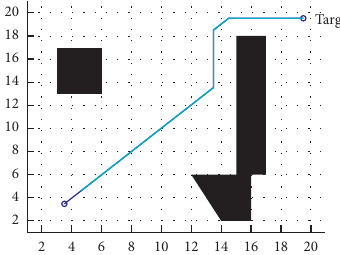
Figure 11: Path planning based on A ∗ algorithm.